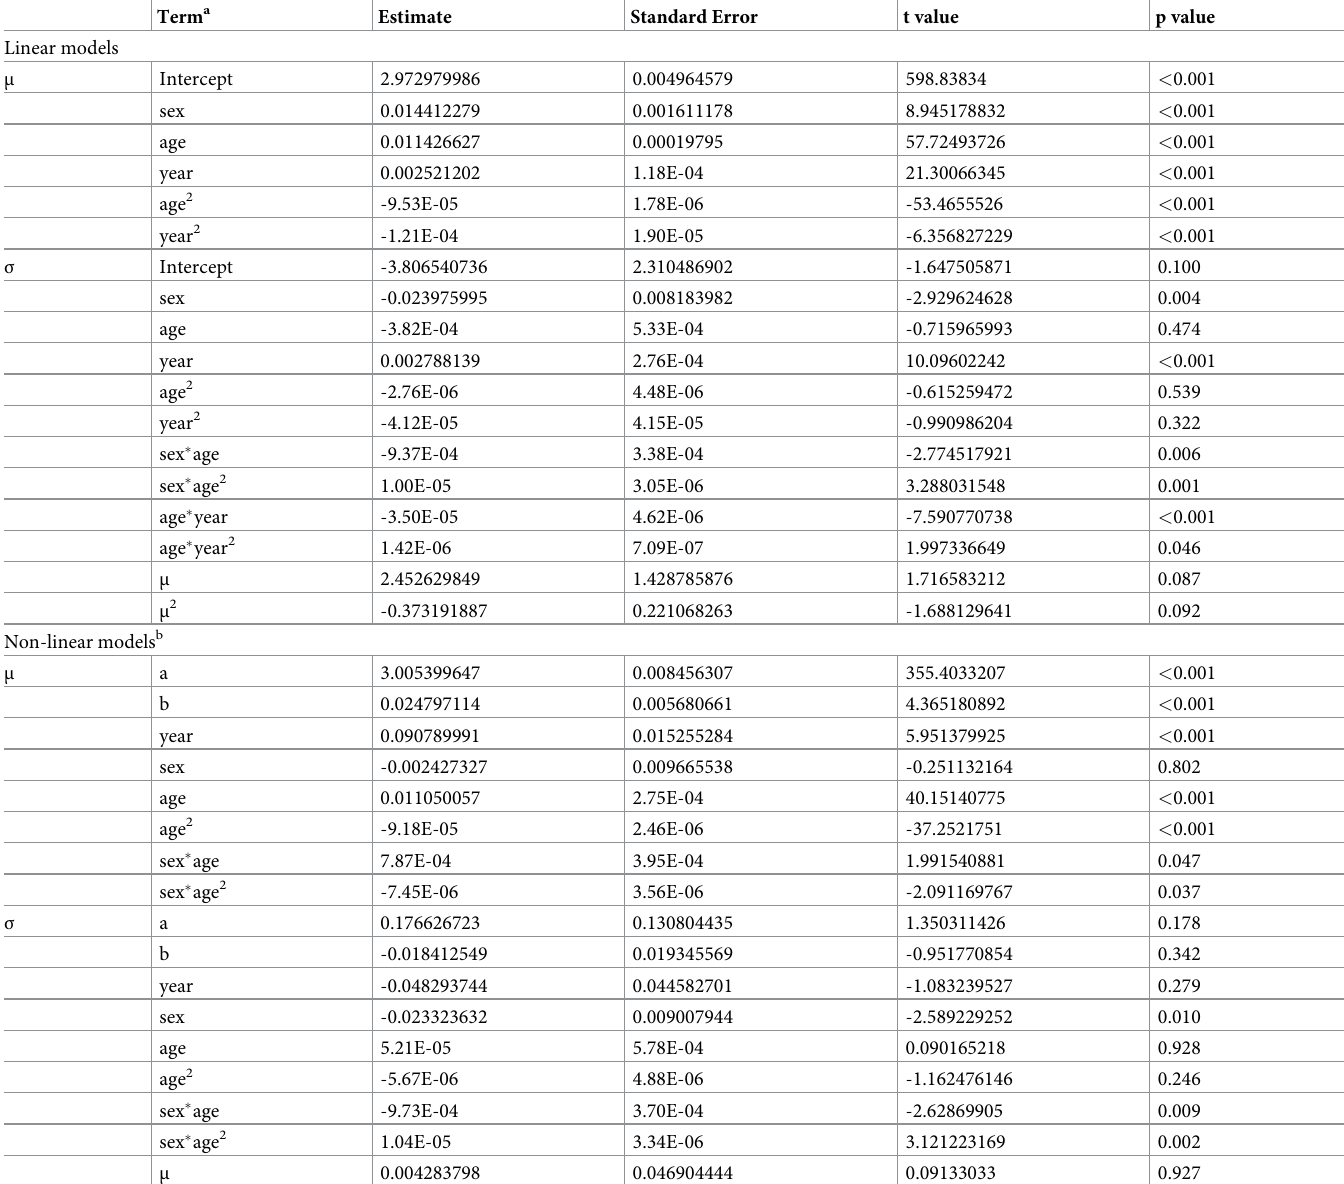
Table 1. Optimal linear and non-linear